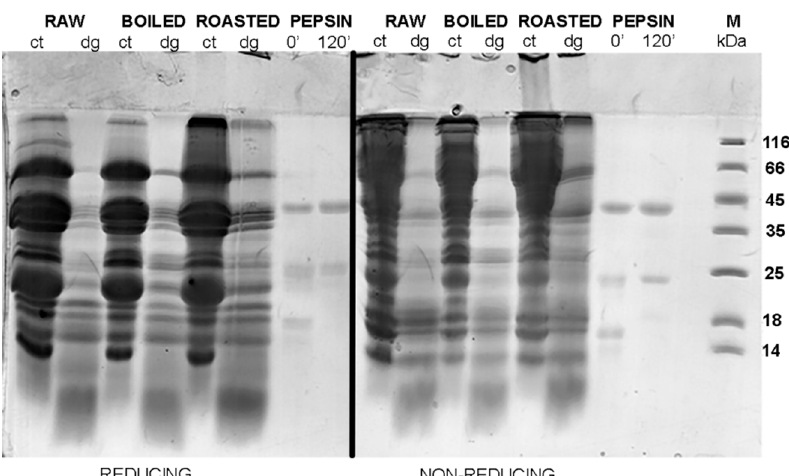
Figure 6. SDS-PAGE protein profiles of insoluble fractions after gastric digestion of raw, boiled, and roasted peanut preparations. SDS-PAGE was performed in reducing and non-reducing conditions, on 14% gels. ct—control at 120 min; dg—digest at 120 min; PEPSIN—controls containing only pepsin at 0 and 120 min; M—molecular weight markers.